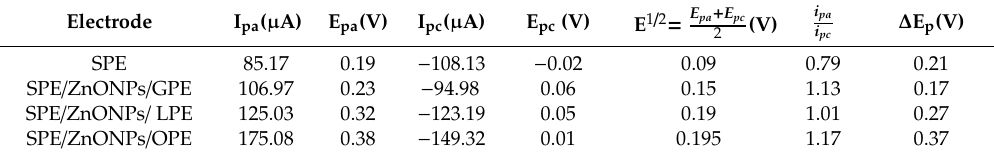
Figure 10. Comparative cyclic voltammograms of 10 mM K 3 [Fe(CN) 6 ] in 0.1 M KCl at pH ≈ 7 on the bare SPE (blue) and modified SPCE / GPE / ZnO NPs (orange), SPE / LPE / ZnO NPs (ash), and SPE / OPE / ZnO NPs (yellow) at the scan rate of 100 mV / s. Table 3. The data of the redox peaks of 10 mM K 3 [Fe(CN) 6 ] in 0.1 M KCl at pH ≈ 7 on the bare SPE, SPCE / GPE / ZnO NPs, SPCE / LPE / ZnO NPs and SPCE / OPE / ZnO NPs at the scan rate of 100 mV /